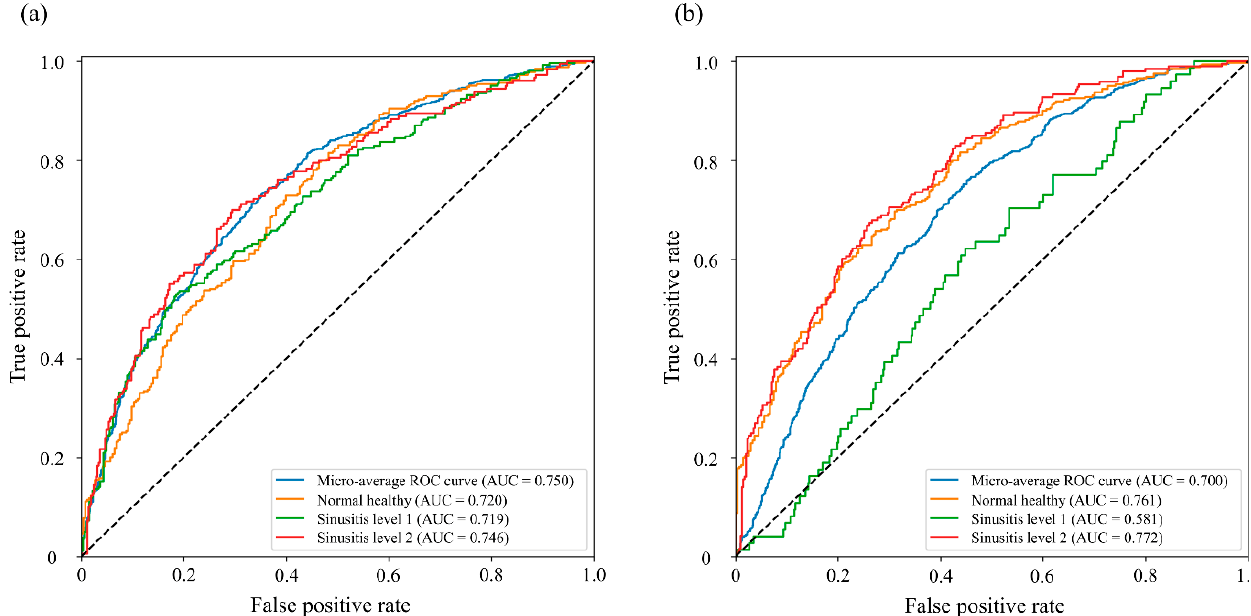
Figure 4. The graphs compare the ROC curves in relation to each class which are divided based on the severity of sinusitis, and the area below the curve indicates the AUC. The graphs were generated by MVNet with Auxiliary loss schemes. The AUC and ROC analyses for the left side ( a ) and right side ( b ) of sinusitis classification performance. The blue, orange, green and red lines indicate the evaluation for total classes (micro-average ROC), normal healthy, level-1, and level-2, respectively. Abbreviations: ROC, receiver operating curve; AUC, area under the